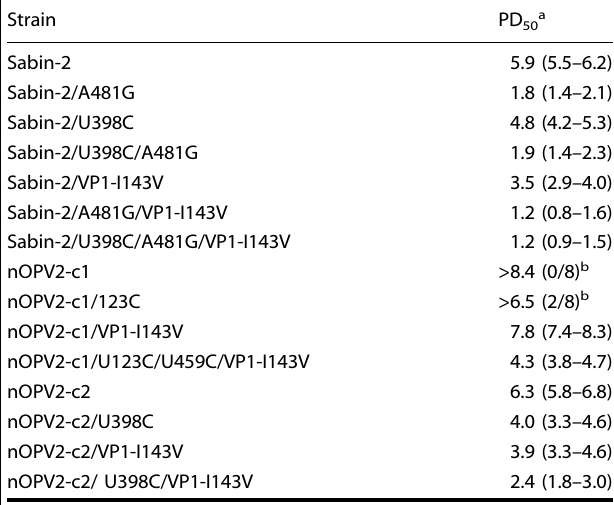
Table 1. 50% paralytic dose (PD 50 ) concentration (log10 CCID 50 ) for various virus strains generated by molecular cloning to contain key mutations identi fi ed in the